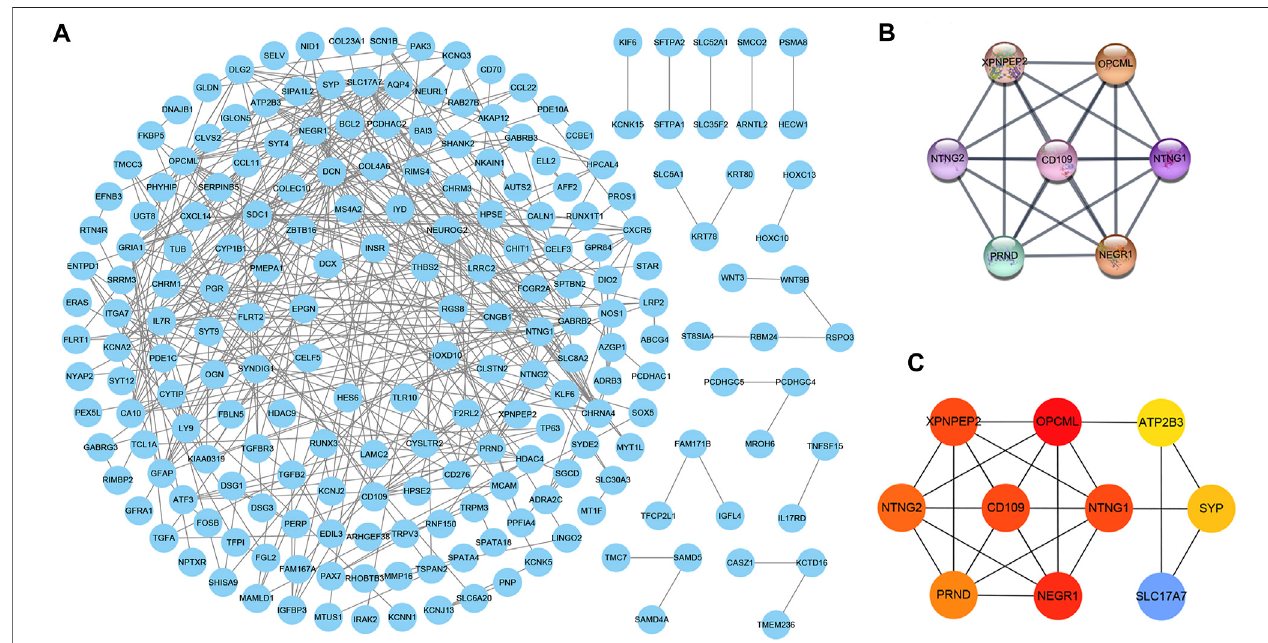
FIGURE4| ThePPInetworkcomposedof303consensusgenes,inwhicheachnodeandedgerepresentseachgene-encodedproteinandlinkbetweenproteins, respectively (A) (B) The top scored module calculated by the MCODE plug-in of Cytoscape software (C) The top 10 scored genes calculated by cytoHubba plug-in of Cytoscape software, and the red represents the score of genes. The deeper the red, the higher the score.